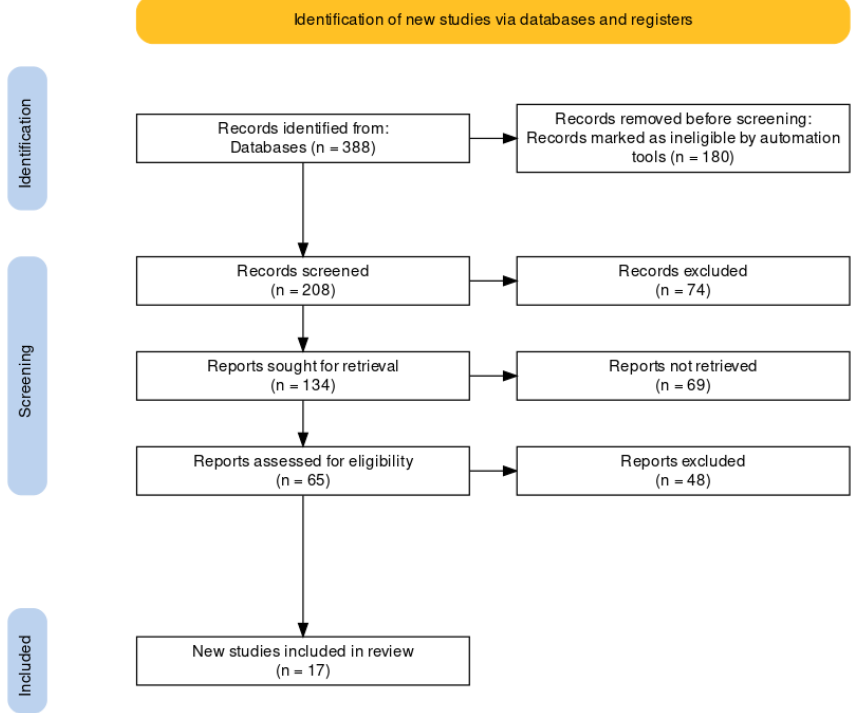
Figure 1. Grouping of articles according to PRISMA methodology. PRISMA chart representing the methodology of the literature review based on the Scopus database. As can be seen, 388 articles started the analysis, but 17 were included in the